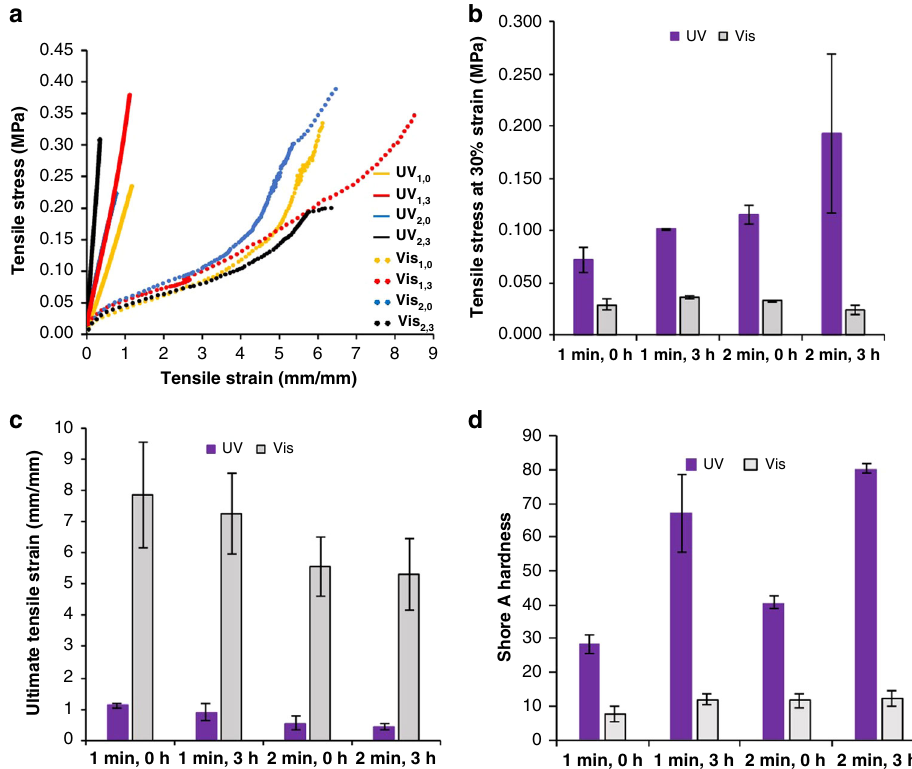
Fig. 2 Representative stress-strain plot and data from tensile testing of HEA-1 samples. a Representative stress – strain plots for uniaxial tensile test HEA-1 specimens each printed with only one light source. To denote each specimen type, we use the light source (UV or Vis) and subscript numbers to indicate the layer cure time in minutes and the thermal post-cure time in hours. For example, UV 1,3 samples were produced using UV light with 1-min layer cure times and a 3-h thermal post-cure. b Comparison of relative stiffness of samples at 30% strain; samples printed with UV (purple) or visible light (light gray) from a single vat. c Comparison of ultimate tensile strain of samples printed with UV (purple) or visible light (light gray) from a single vat. d Comparison of Shore A hardness values; samples printed with UV (purple) or visible light (light gray) from a single vat. All error bars correspond to one standard